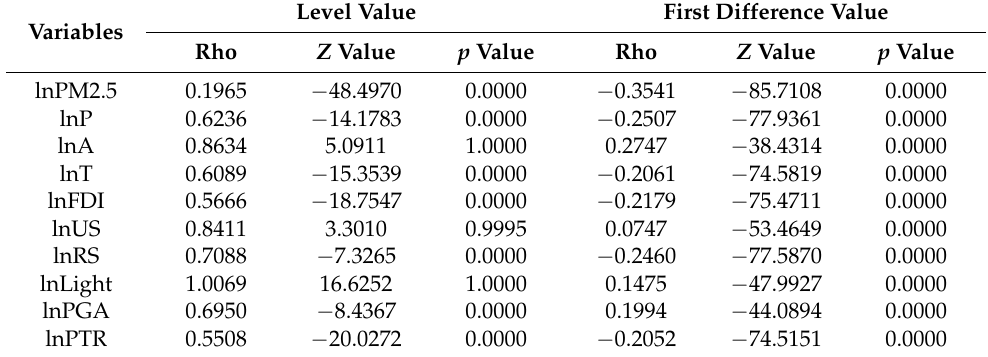
Table 3. Unit root test.